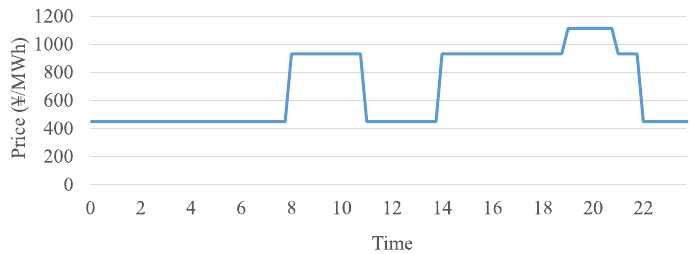
Figure 7. Electricity price of the